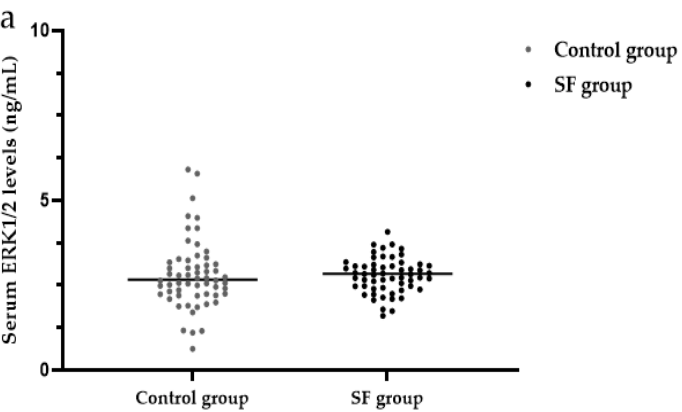
Figure 7. Analysis of serum ERK1/2 levels in the SF group and control group. ERK1/2: extracellular signal-regulated kinase 1/2.